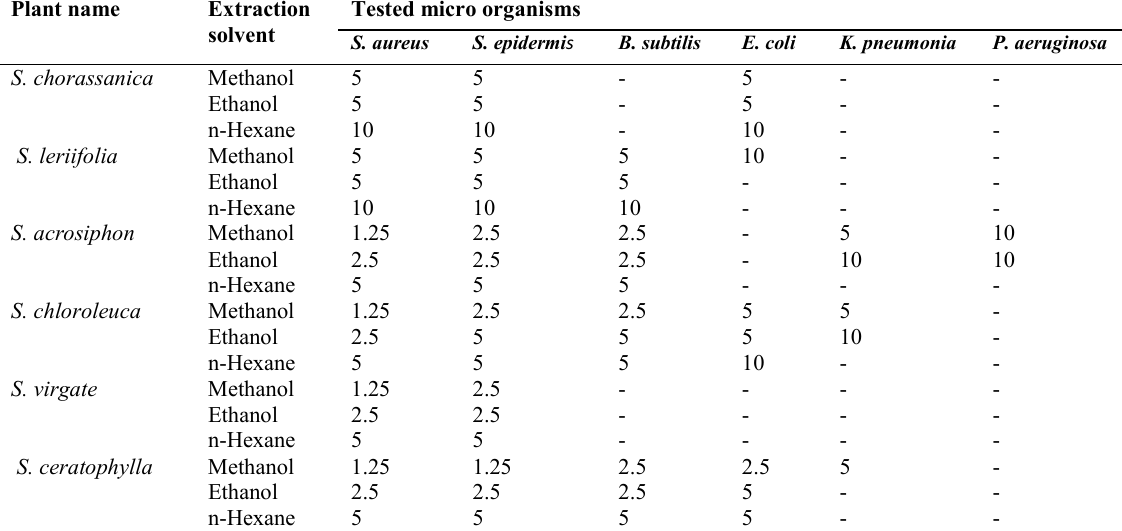
Table 3. Antibacterial activity (MIC) of the aerial part extracts of Salvia species. a) Minimum inhibitory concentration (MIC) of the plant extracts in bacterial suspension in the nutrient broth media (mg/ ml) - : No